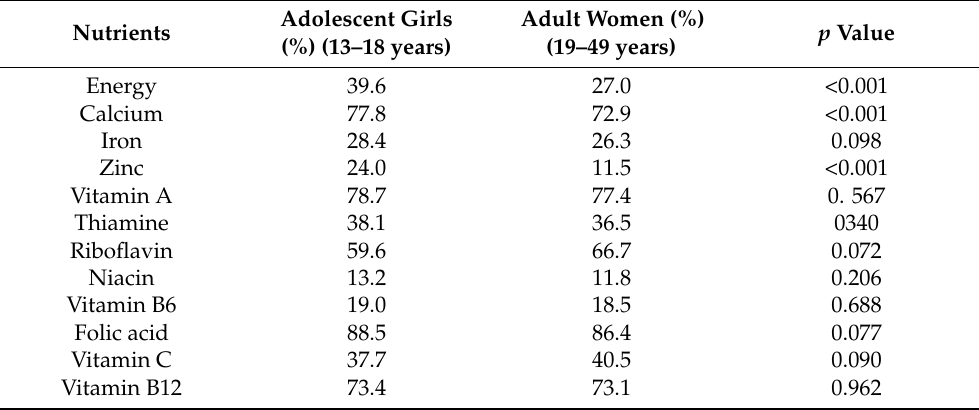
Table 3. Prevalence of inadequate dietary nutrient intakes in adolescent girls and adult women.